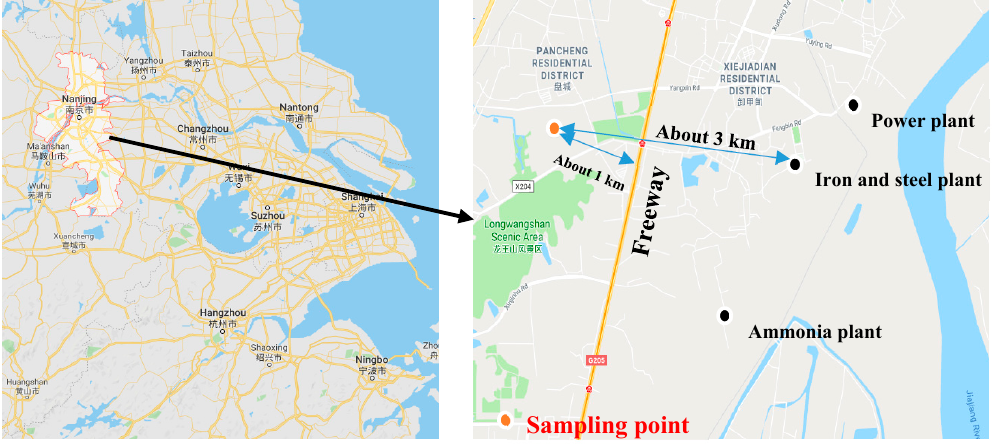
Figure 1. Position of the sampling point.